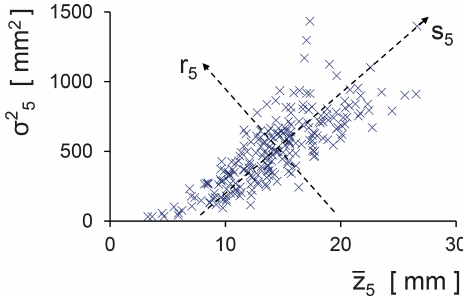
Figure 5. Scatterplot of sample mean z 5 and sample variance σ 2 calendar month “May” along with the principle components s 5 and r 5